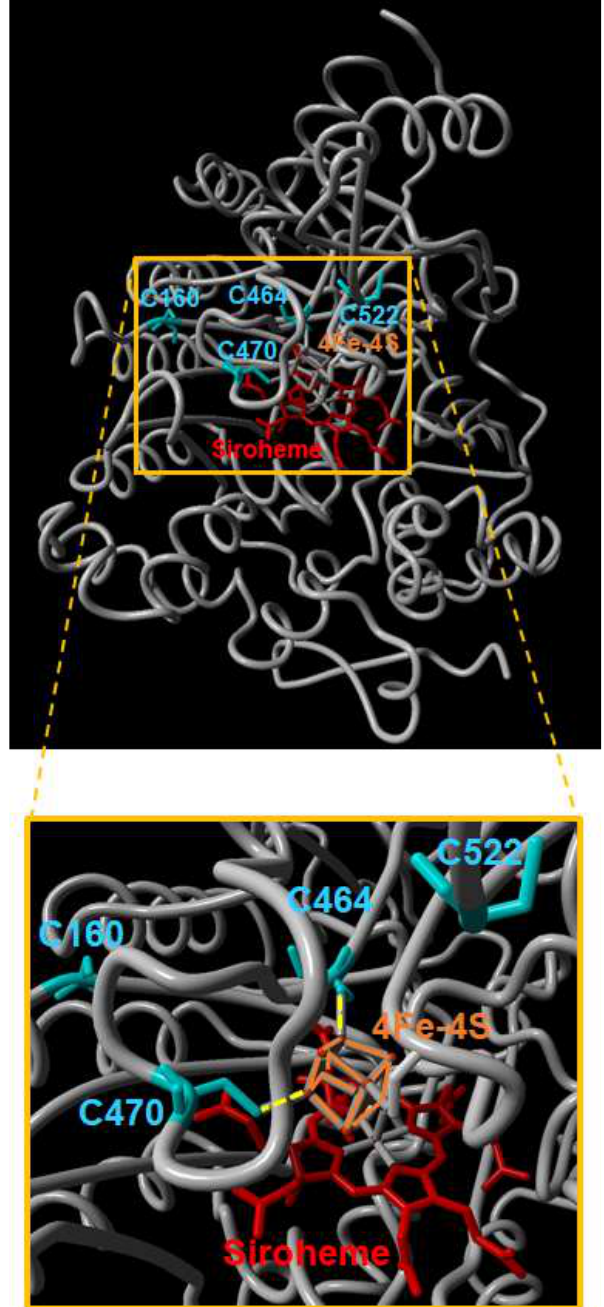
Figure 6. Location of S-nitrosylated cysteines in the 3D model of NiR1. The NiR1 3D structure was modelled in the basis of the 3D structure obtained from spinach ferredoxin-nitrite reductase crystals (PDB code 2akj) using the Yasara application (www.yasara.org). The position of the siroheme (red)